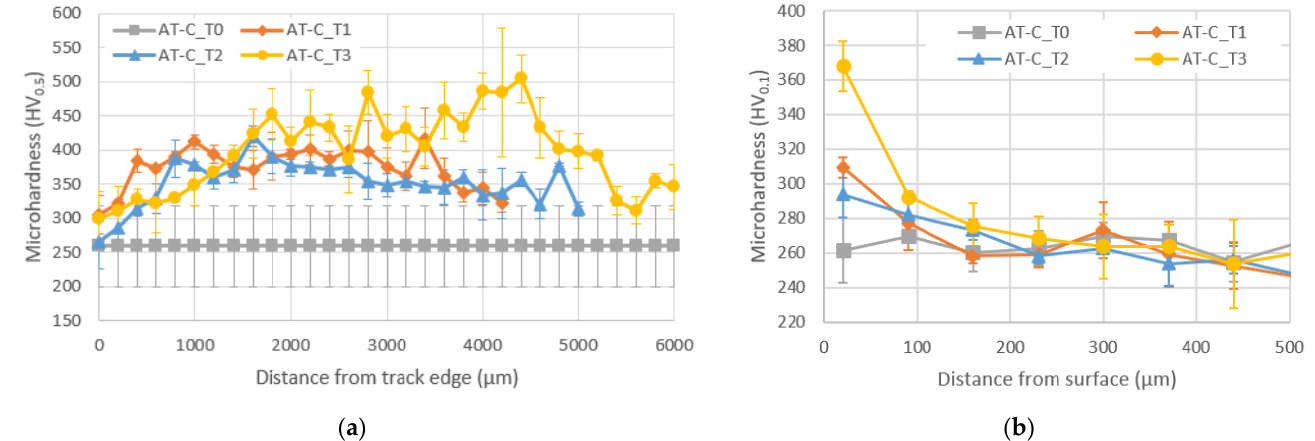
Figure 8. Microhardness results performed ( a ) on the surface of the tracks along their width and ( b ) on cross-sections for Ring AT-C.